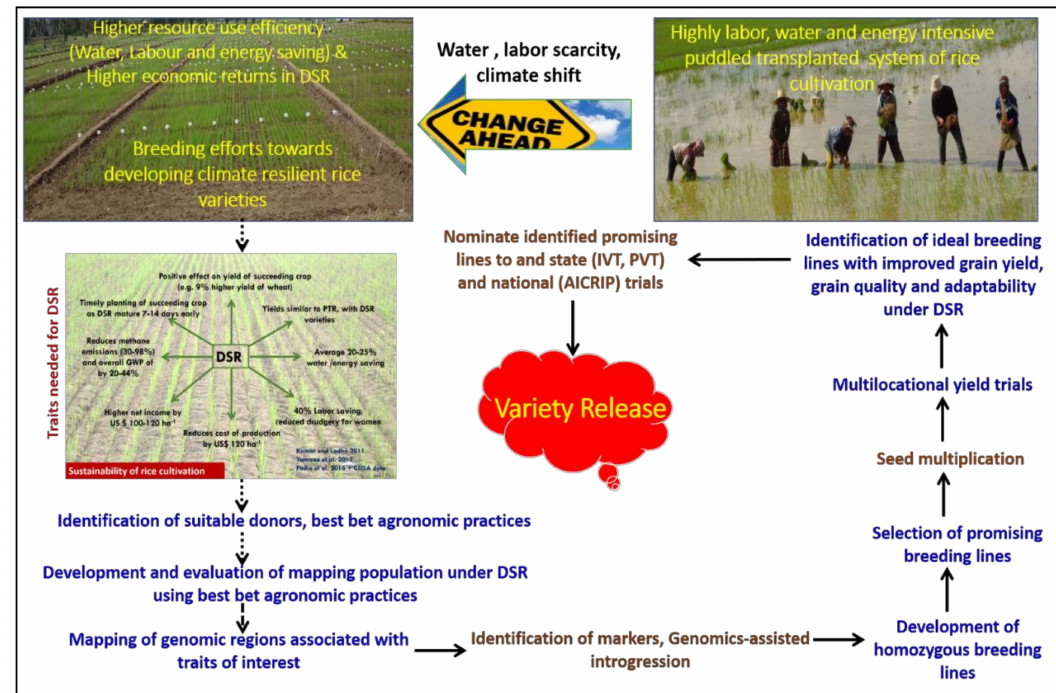
Figure 5. The schematic representation of the steps involved in the development and release of direct seeded adapted rice varieties. The identification of donors, traits, best bet management practices, development of suitable mapping populations and selection of promising breeding lines with improved grain yield, grain quality and adaptability are essential steps in the development and release of suitable DSR-adapted rice varieties. Identification of best management practices for the proper evaluation of breeding material underlies the success of DSR variety and